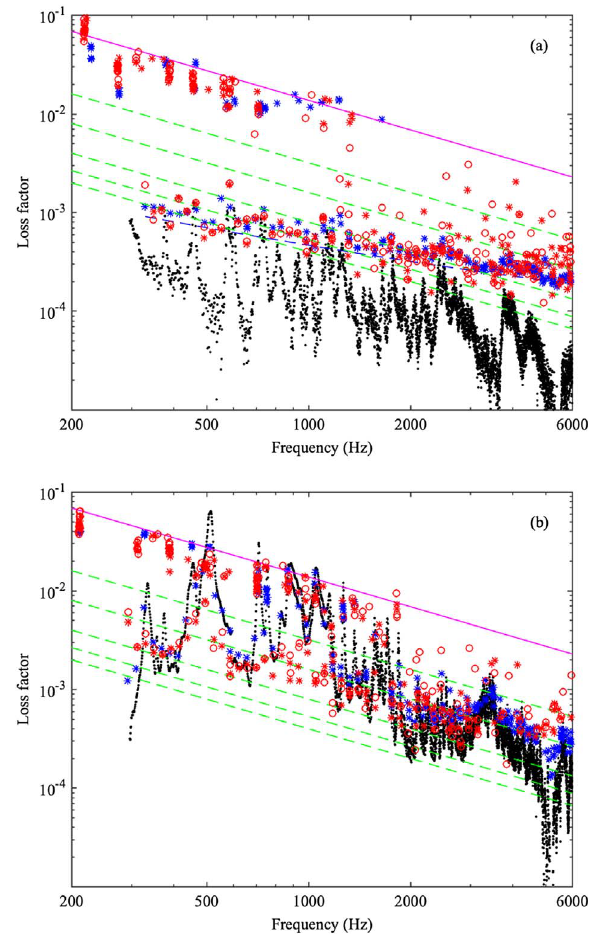
Figure 11. Loss factor versus frequency for modes excited by plucking the top string of (a) the guitar; (b) the banjo. Red circles and stars: measured values; blue stars: values from synthesised notes; black dots: predicted loss factor for energy fl ow into the body alone, calculated from the measured admittances shown in Figure 5. The analysis method cannot detect modes signi fi cantly above the magenta line. Green dashed lines indicate decay time constants ( xg ) (cid:1) 1 = 50 ms (top line), 100 ms, 200 ms, 300 ms and 400 ms (lowest line). Blue dashed line in (a) shows the internal loss factor of the